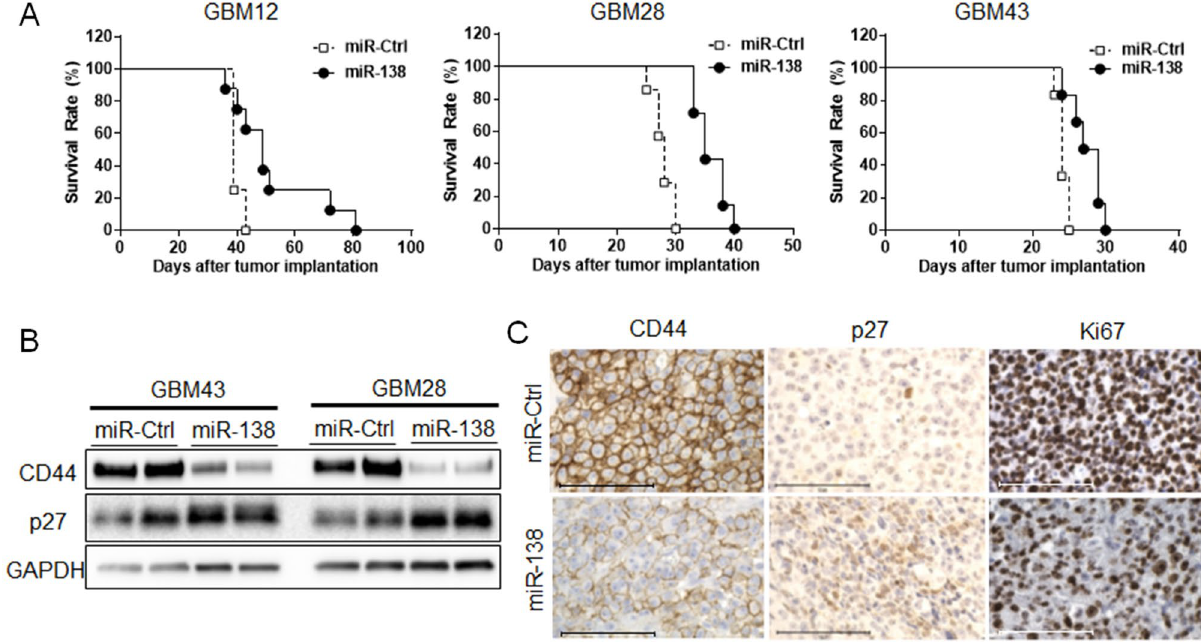
Figure 5. miR-138 reduces tumorigenicity of GBM cells in orthotopic in vivo model. ( A ) Mouse survival was analyzed by Kaplan–Meier survival curve. Intracranial xenograft tumor was induced by implanting GBM cells transduced with miR-138 or miR-Ctrl expressing lentiviruses. ( B ) The expression levels of CD44/p27 axis were analyzed by western blotting on the harvested mice brain tumor tissues that were derived from GBM cells (GBM28 or GBM43) with miR-138 or miR-Ctrl expression. ( C ) Representative images of tissue sections from mice brain tumor tissues after immunohistochemistry staining with anti-CD44 or anti-p27 for the change of target gene expressions by miR-138, and Ki76 for cell proliferation. Scale bars indicate 100